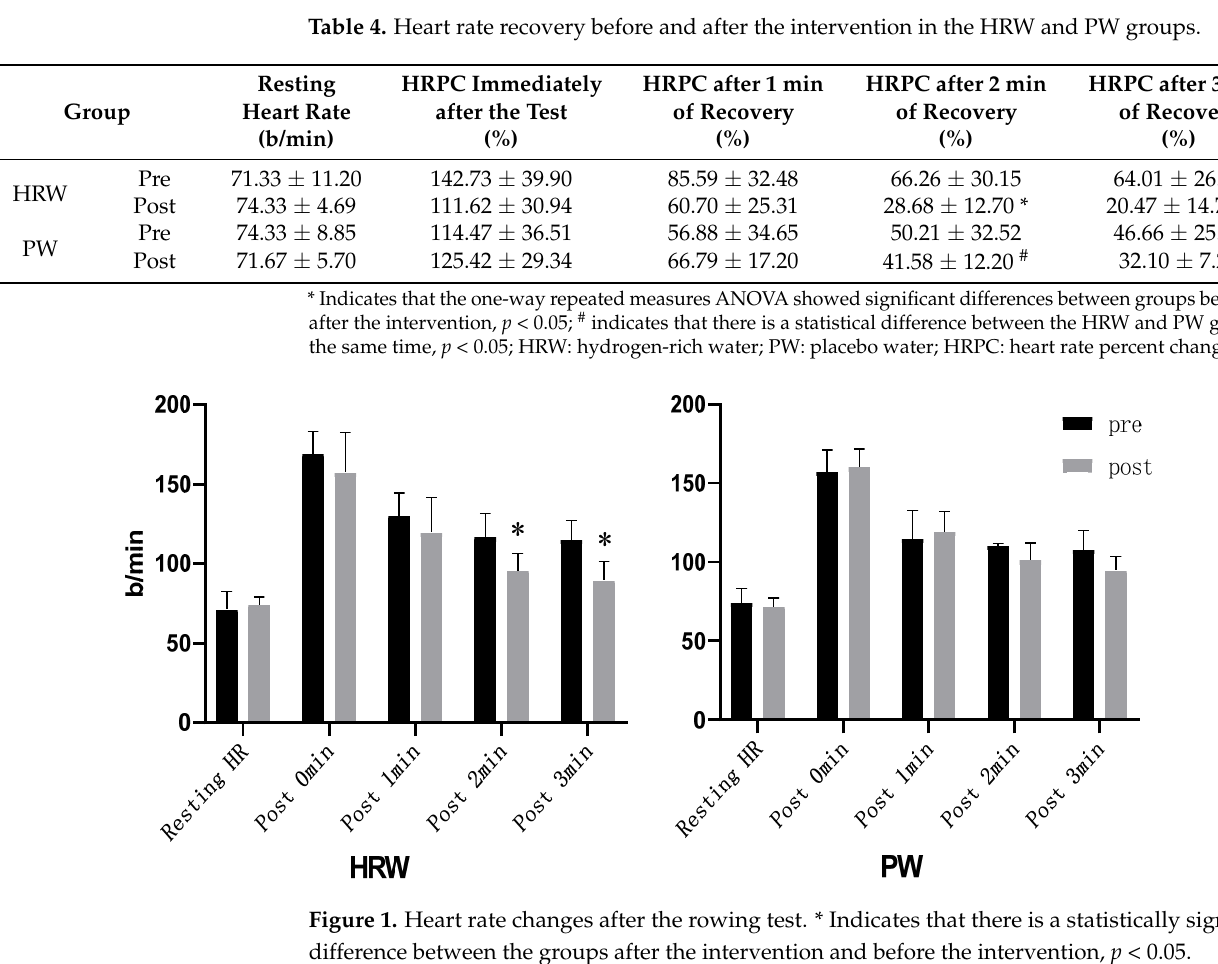
Table 4. Heart rate recovery before and after the intervention in the HRW and PW groups.